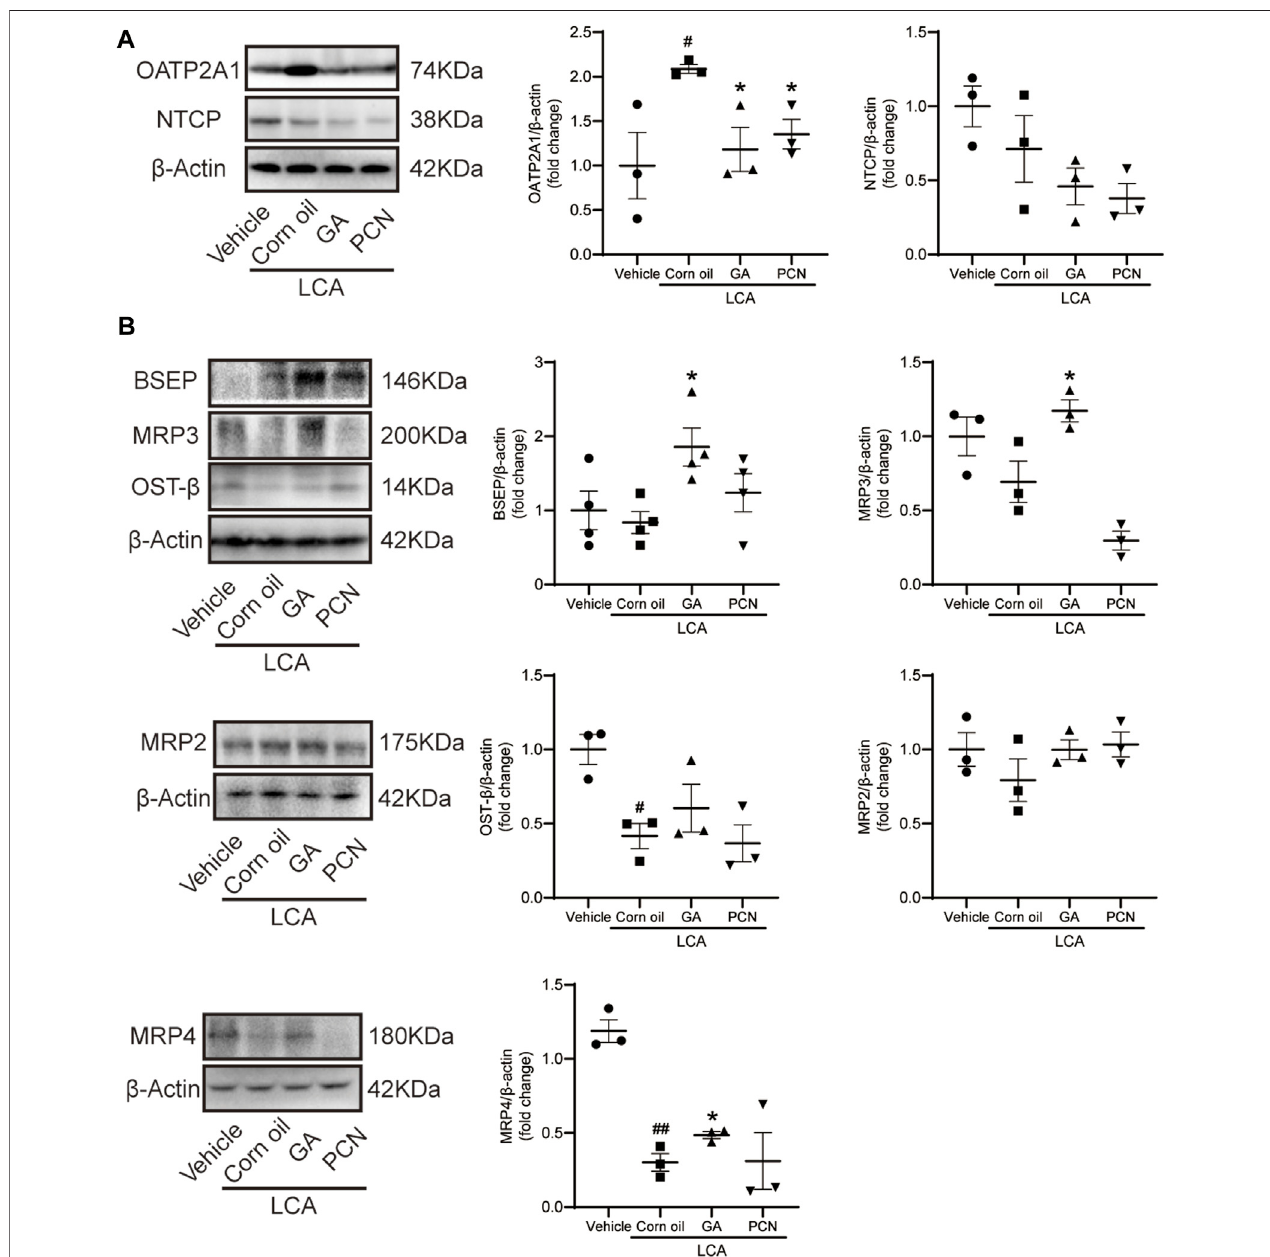
FIGURE6| GAalteredhepatic expressionofbileacidtransportersinLCA-inducedcholestaticliverdamage. (A) Westernblotwasusedtomeasuretheexpression ofuptaketransporters,includingNTCPandOATP2A1; (B) proteinlevelsofef fl uxtransporters,includingBSEP,MRP2,MRP3,MRP4,andOST- β .Dataarepresentedas mean ± SD ( n = 5). # p < 0.05 and ## p < 0.01 vs. vehicle group; p p < 0.05 vs. LCA group.